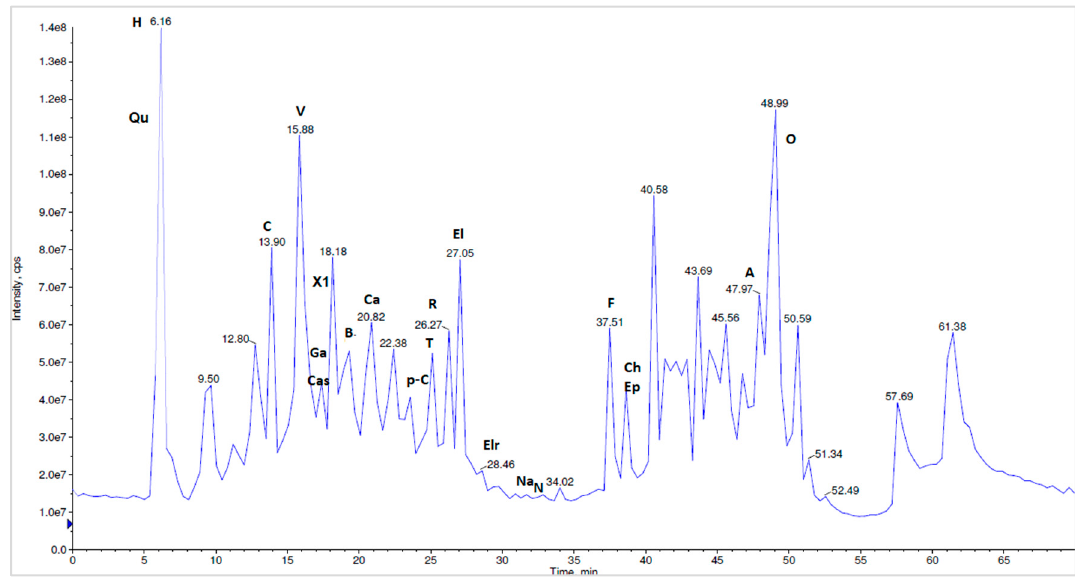
Figure 11. The LC-MS/MS chromatographic separation of the methanolic N. alba root extract